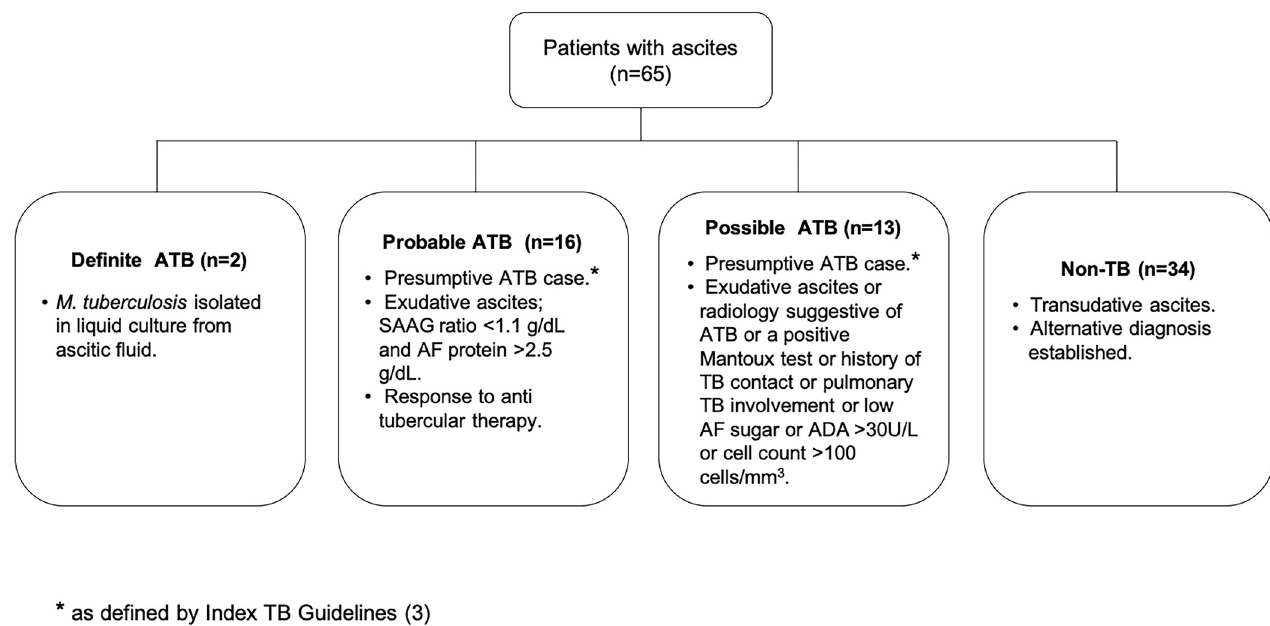
Fig 2. Composite reference standard used for classification of patients enrolled in the